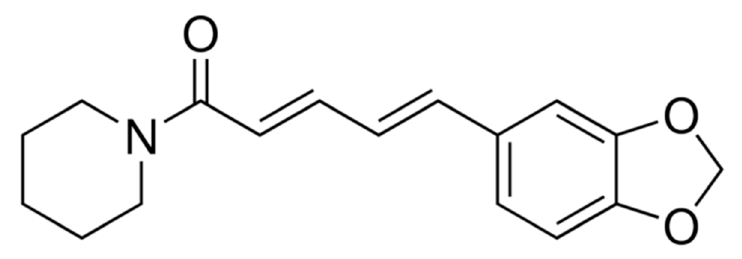
Figure 1. Chemical structure of piperine (PPN).